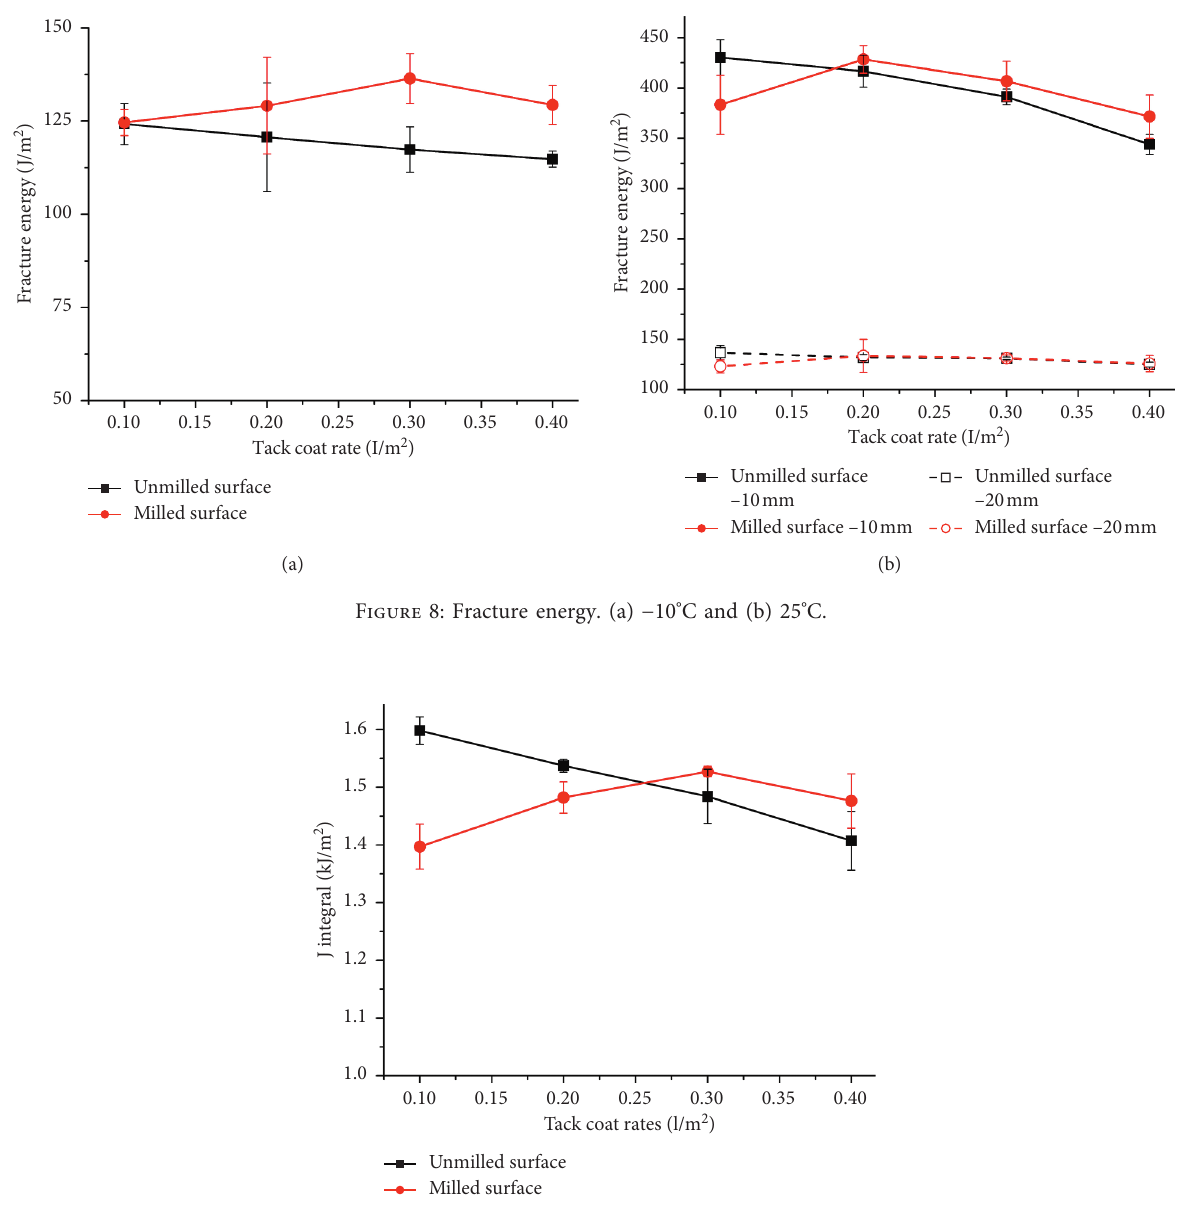
Figure 9: J integral. Table 5: Three-way ANOVA